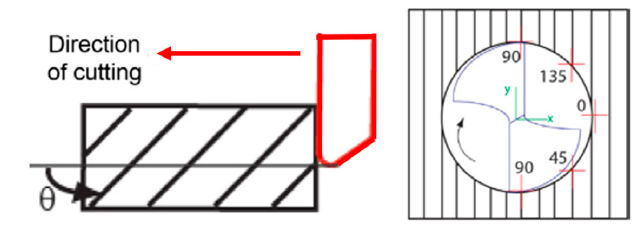
Figure 9. Diverse simultaneous fiber orientations along the cutting edge. 4.2. Sensor Signal Pre-Processing The raw thrust force and torque sensor signals acquired during the drilling tests included signal portions corresponding to time periods before and after real machining. With the aim to extract sensorial information only when the tool is actually removing material, a signal segmentation procedure was performed on the thrust force signals and synchronically extended to the torque signals. The identification of the start and end of the actual machining portion of the signal was carried out on the basis of thresholds set on the moving average of the thrust force signals. In Figure 10, the thrust force signal segmentation for hole n° 6 with drilling parameters 6000 rpm and 0.15 mm/rev is reported, showing a drop of thrust force at the interface between the two laminates which are in contact with their bag sides characterized by very irregular surfaces. In Figure 11, the thrust force signals are reported versus the increasing number of holes (from 1 to 60) for the operating conditions 2700 rpm–0.15 mm/rev showing that the thrust force and its variance significantly grows with increasing number of holes (ranging from 50 N for hole n.1 to over 200 N for hole n.60). Figure 12 shows the torque signals versus the number of holes for 2700 rpm– 0.15 mm/rev drilling conditions highlighting the same previous behaviour.